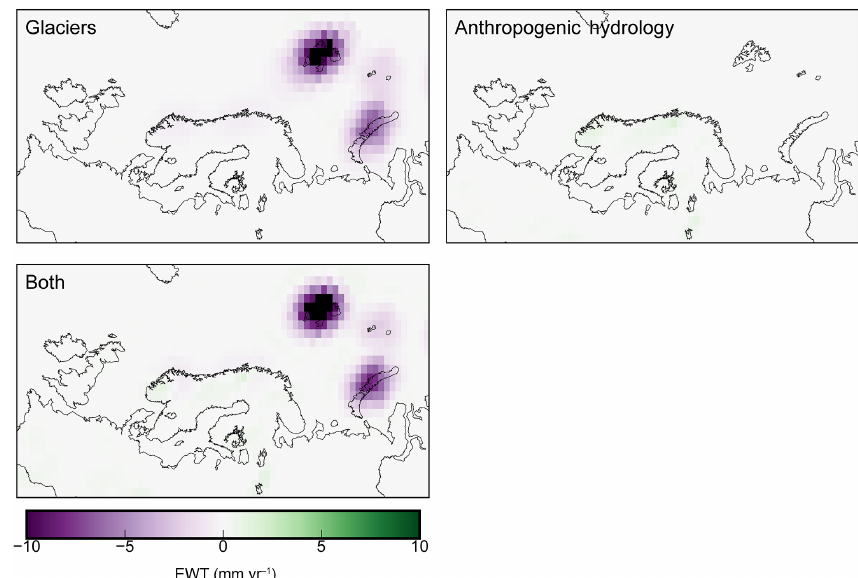
Figure A2. Individual and combined contributions to the correction applied to the GRACE data (combined is the same as Fig. 2c).